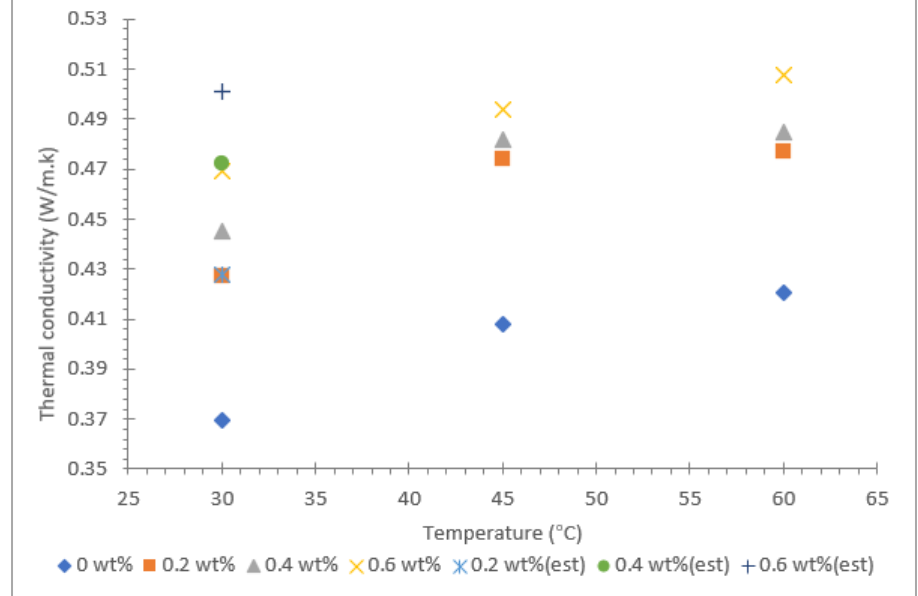
Figure 8. Thermal conductivity of palm oil/Al 2 O 3 -TiO 2 hybrid nanofluid. 3.4. Dynamic Viscosity and Rheological Properties of Base Oils and Their Hybrids The dynamic viscosity of the soybean oil, coconut oil, palm oil and their hybrid nanofluids were measured using a modular compact rheometer (Anton Paar RheoCom- pass) for three different temperatures: 30, 45 and 60 °C. The results for dynamic viscosity for all three vegetable base oils and their hybrids with Al 2 O 3 -TiO 2 nanoparticle mass con- centrations between 0.2 and 0.6 wt.% are presented in Figures 9 – 11. The viscosity of the base fluid is plotted in the same graph and labelled as 0 wt.%. In addition, Brinkman ’ s viscosity model was used to estimate the viscosity for all three hybrid nanofluids. The computed theoretical estimated value was fitted in the same graph for the 30 °C temper- ature data . Among the three base oils, coconut oil was found to have the lowest viscosity